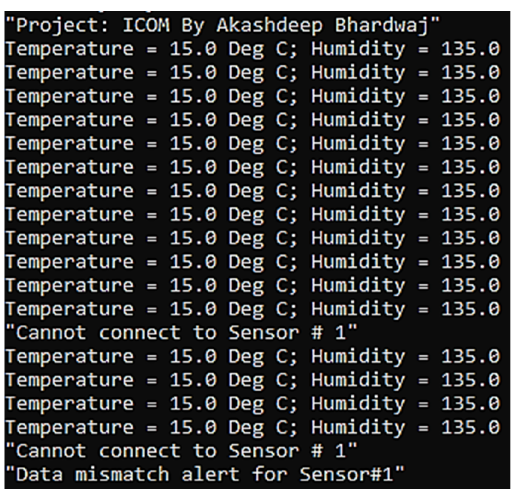
Figure 6. Compromised temperature and humidity sensors.